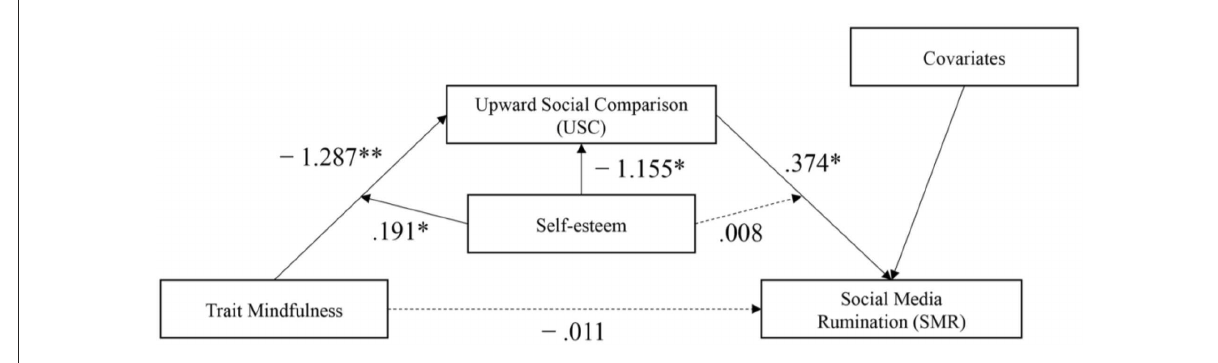
FIGURE3 Moderated mediation model. Dashed lines represent nonsignificant relation. ** p < 0.01 and * p <